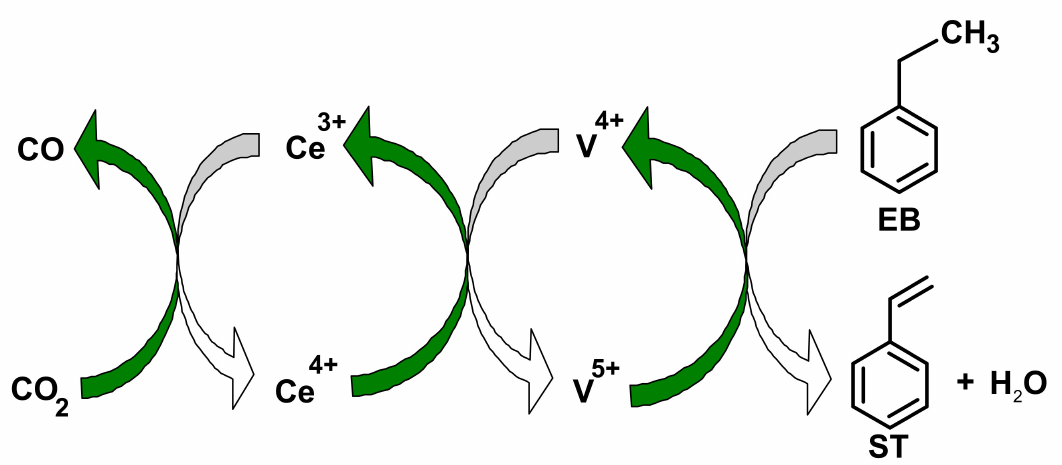
Figure 5. Red-ox cycle for CO 2 -ODEB over the ceria-promoted vanadium catalyst. (Reproduced from [48]; copyright (2011),